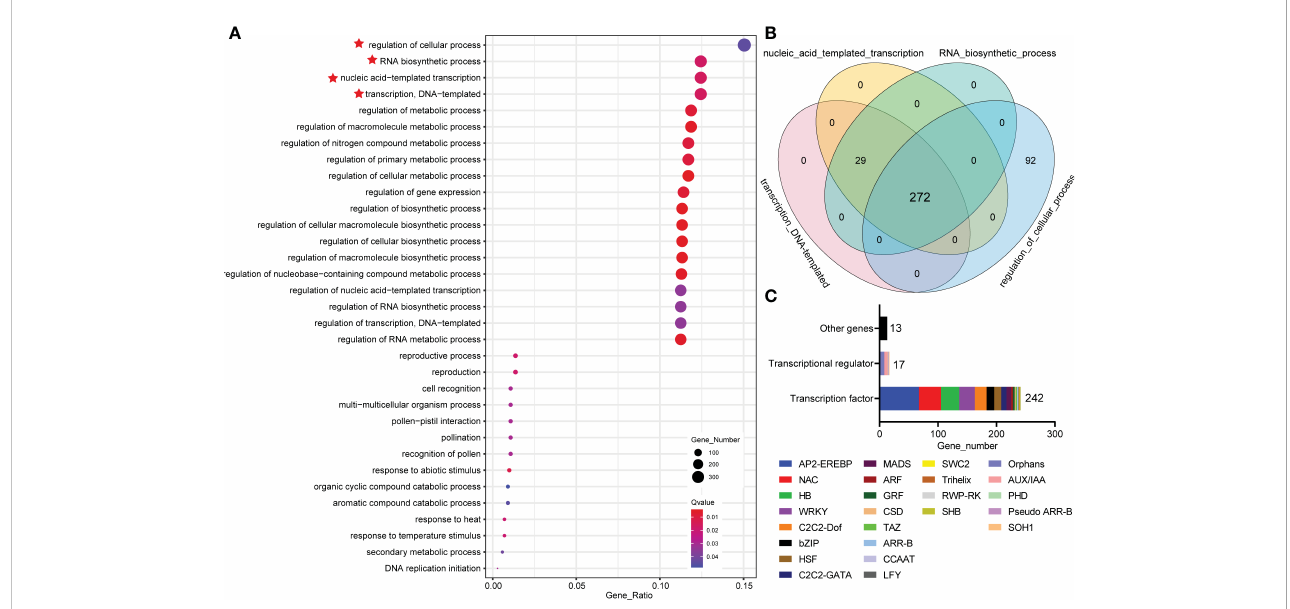
FIGURE 6 Comparative transcriptome analysis of the stem of WT and MdWRKY87 -OE tobacco plants. (A) Functional categorization of DEGs based on the biological process of Gene Ontology (GO). The symbol red star represent the top 4 GO terms. (B) Venn diagram of DEGs in top 4 GO terms based on the